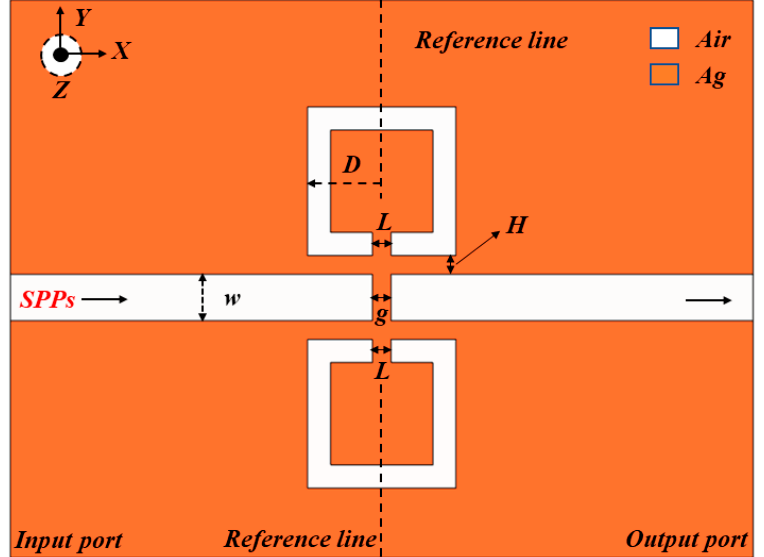
Figure 1. A 2D schematic diagram of a MIM waveguide with double symmetric SSRC.